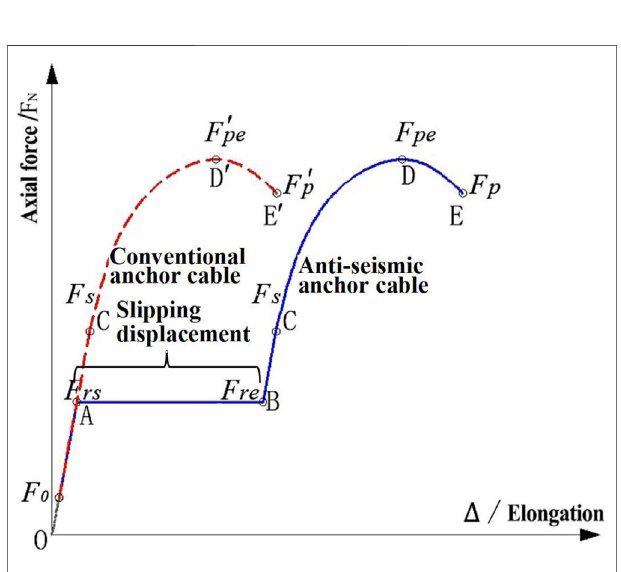
FIGURE 5 | Axial force-elongation curve of conventional and anti- seismic anchor cables.